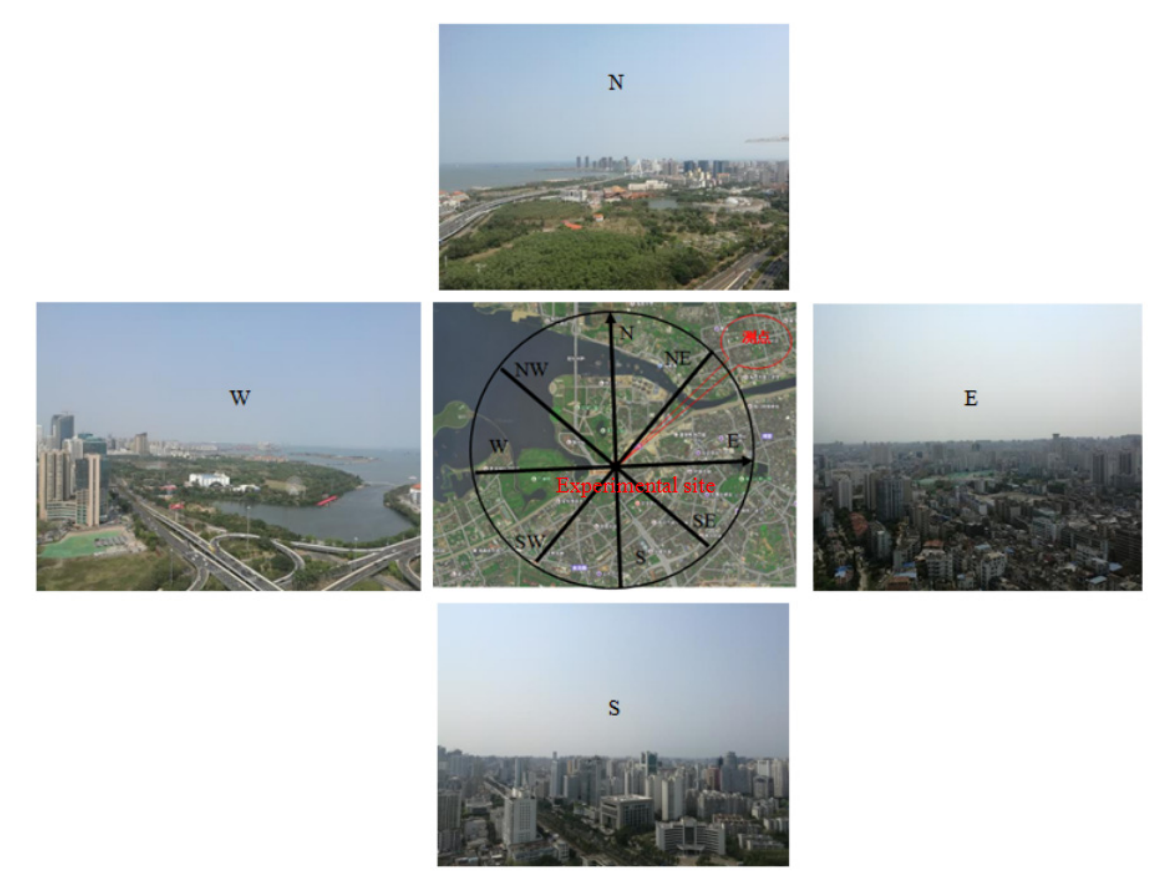
Figure 2. The surrounding building environment near the experimental